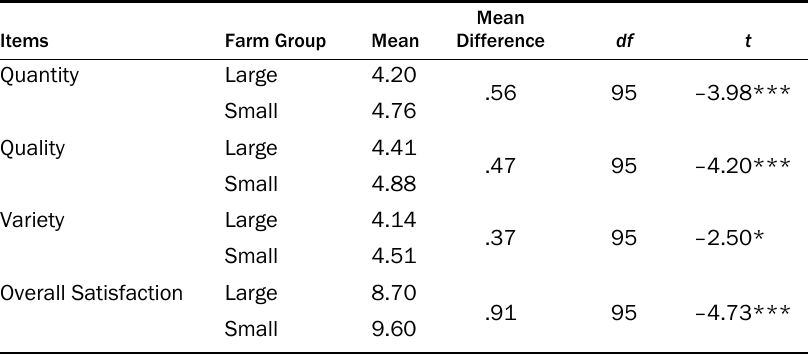
Table 3. Independent Samples t-test for Mean Satisfaction Scores